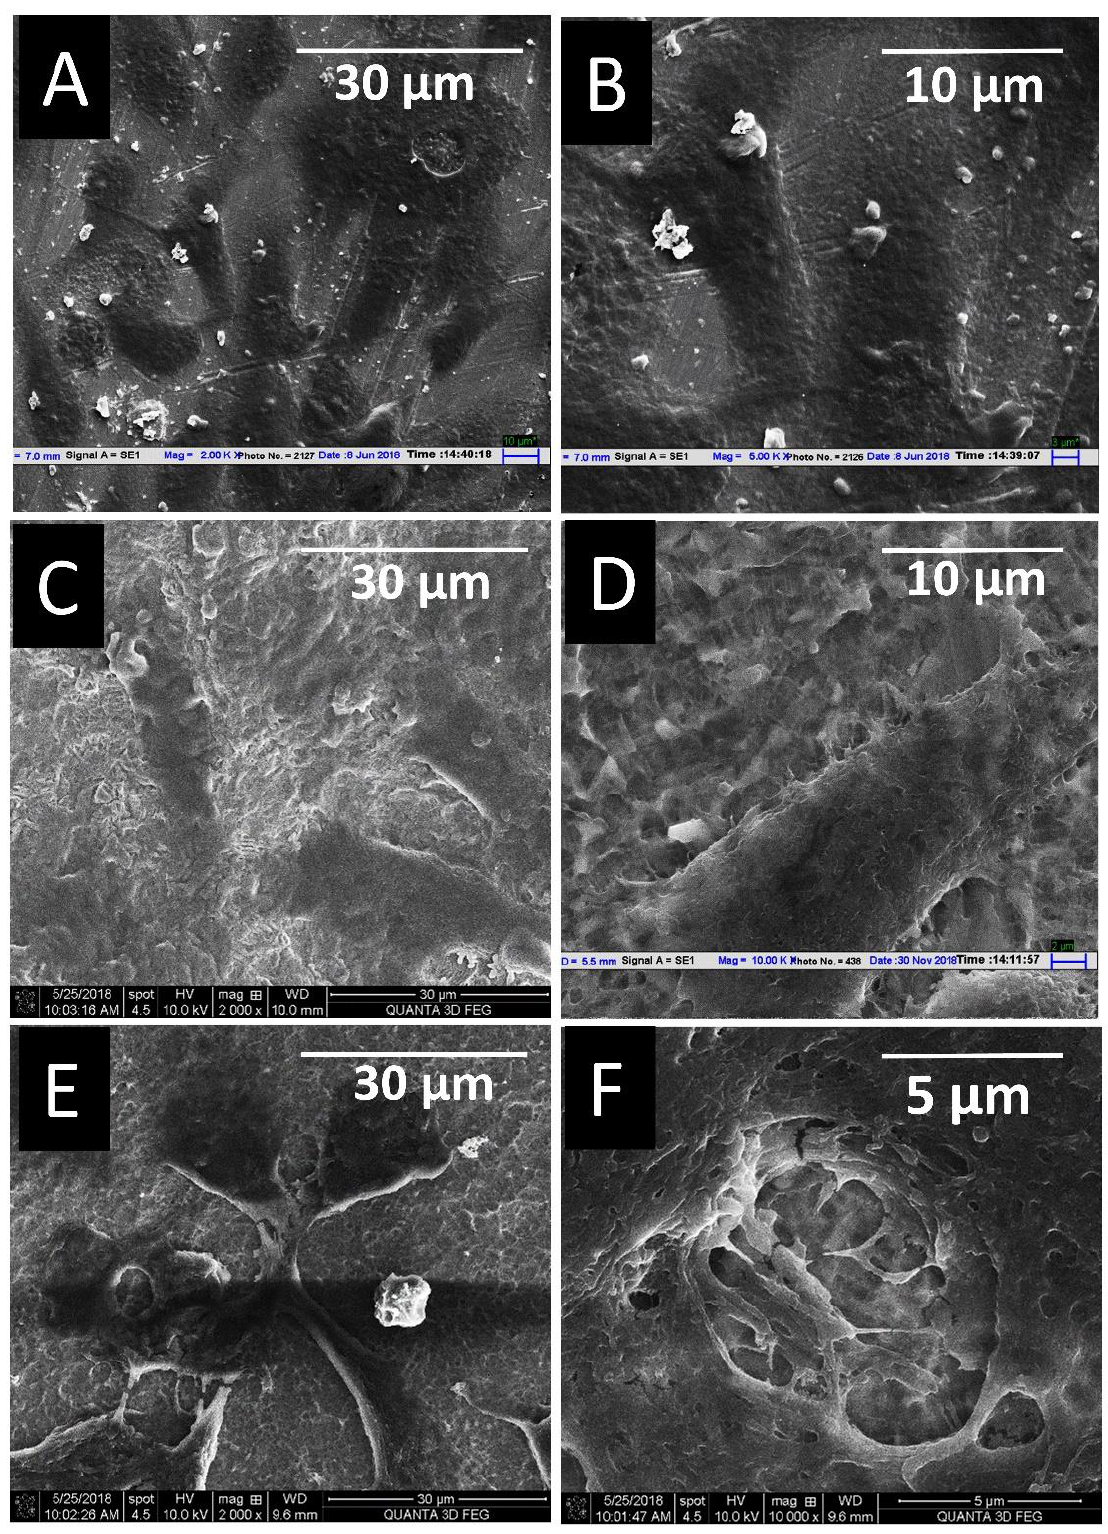
Figure 11. SEM Images of MG 63 cells on machined ( A , D ), RT etched ( B , E ), and HT etched ( C , F ) surfaces after three days of culture.